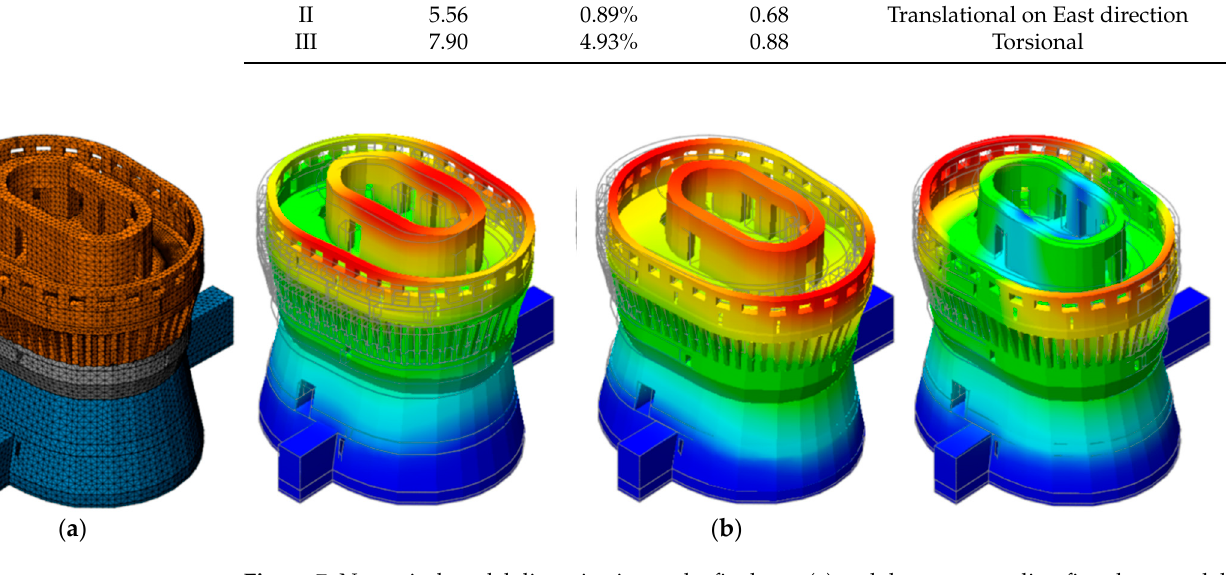
Table 3. Comparison of the modal frequencies and shapes between the starting FEM and the OMA results.